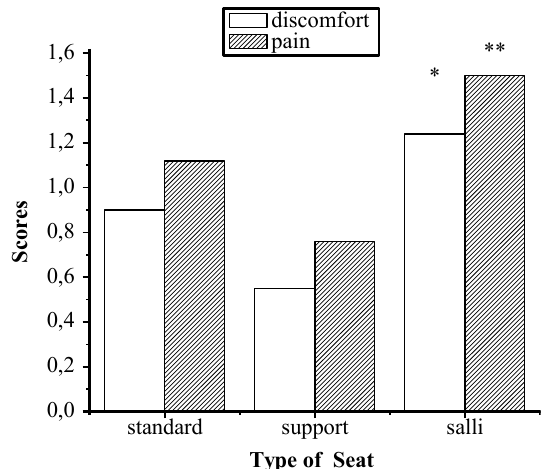
Figure 5 – Scores from discomfort scale and Pain Numerical Rating Scale (PNRS) obtained in each type of seat (standard, ischial support and salli). *significant difference in relation to the discomfort vari - Figure 7-Scores of discomfort and pain obtained in each instant of trial able on the support seat; **significant difference in relation to the (pre, middle and post).* and ** significantly higher than pre instant. PNRS variable on the ischial support seat.